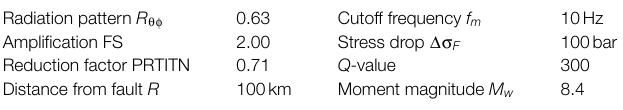
TABLE 4 | Fault parameters of Tonankai earthquake in 1944.